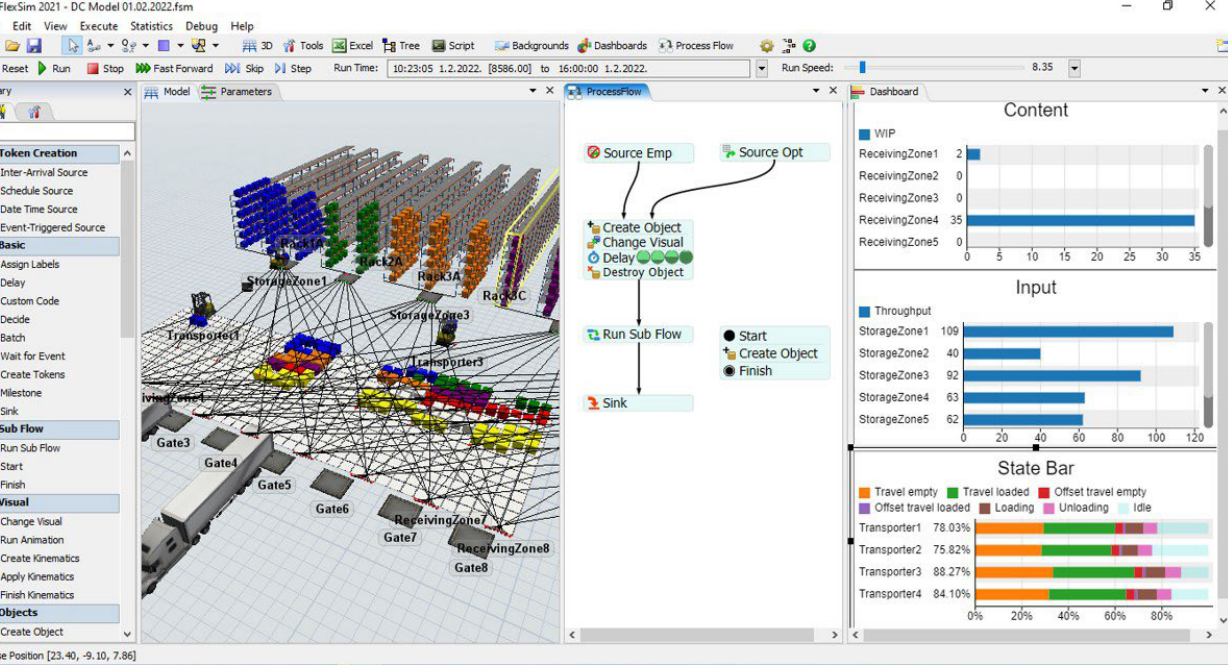
Figure 3. The simulation model.